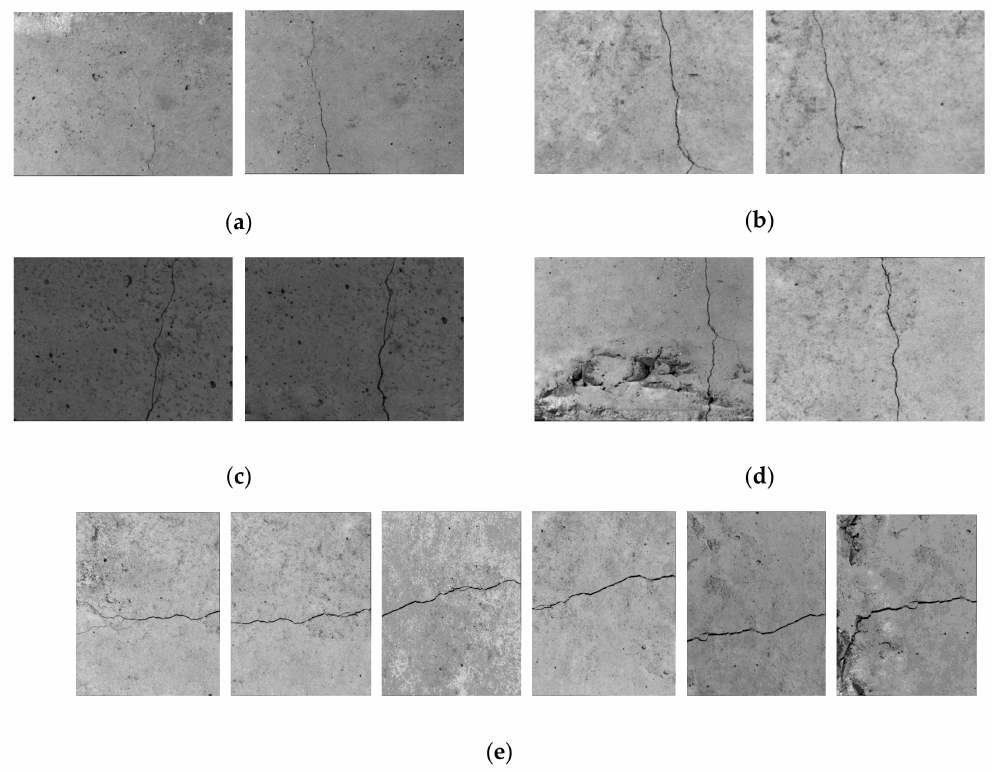
Figure 19. Images to be stitched ( a ) Splicing of fine cracks at the ends; ( b ) Splicing of cracks under good light conditions; ( c ) Splicing of cracks under poor lighting conditions; ( d ) Splicing of cracks under strong noise interference conditions; ( e ) Splicing of complete cracks under multiple